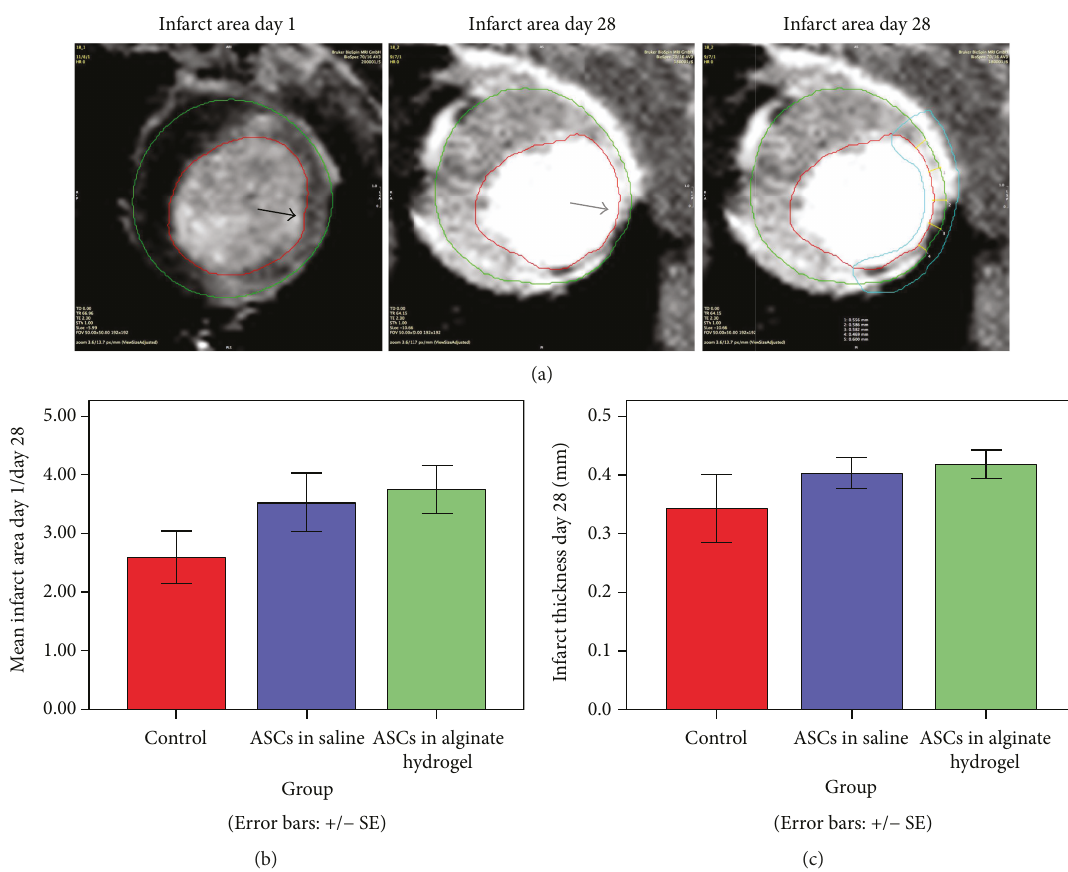
Figure 4: Infarct size. (a) Analysis of infarct area using representative images. Black arrow annotates gadolinium-enhanced area 15 minutes after IV injection at day 1. Grey arrow annotates clear thinning of the myocardium at day 28. The turquoise contour encircles the infarct area in the myocardium (lumen is not a part of the generated area), and the yellow lines across the de fi ned infarct area are length measurements of infarct thickness. (b) Ratio of enhanced area at day 1 and area of myocardial thinning at day 28. (c) Infarct thickness at day 28 after infarction. For both (b) and (c), n = 38